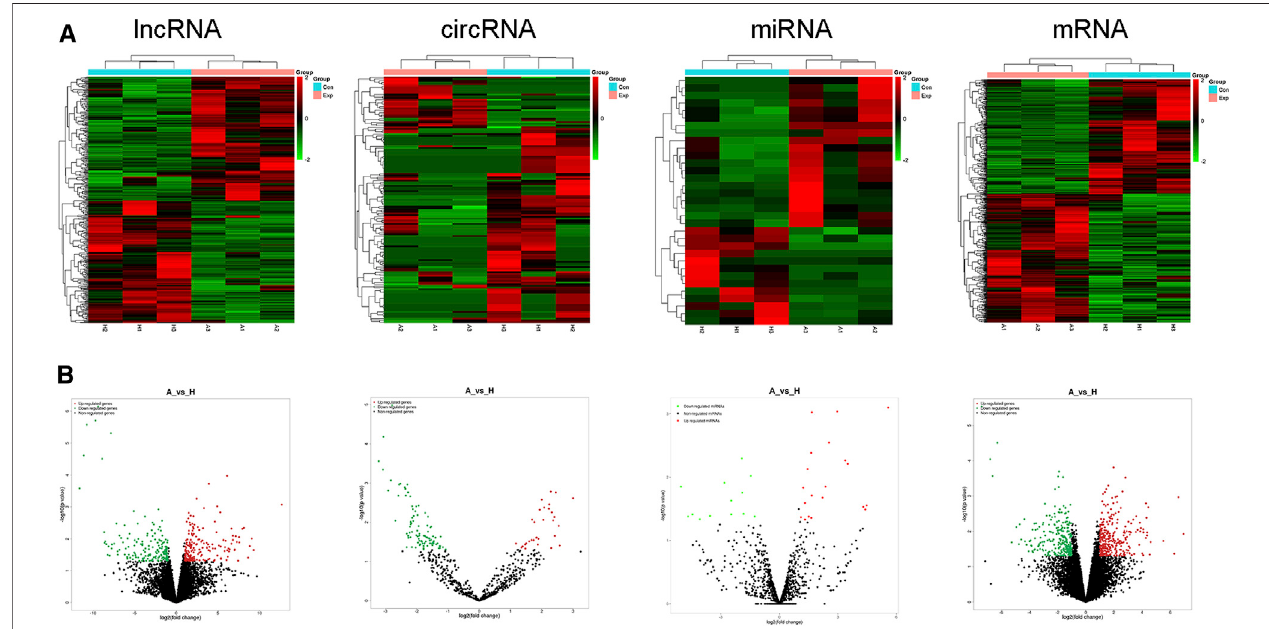
FIGURE 3 | Expression pro fi les of lncRNAs, circRNAs, miRNAs, and mRNAs. Differently expressed ncRNAs and mRNAs in the HC group and AIH group. (A) Volcano plot. (B) heatmap.